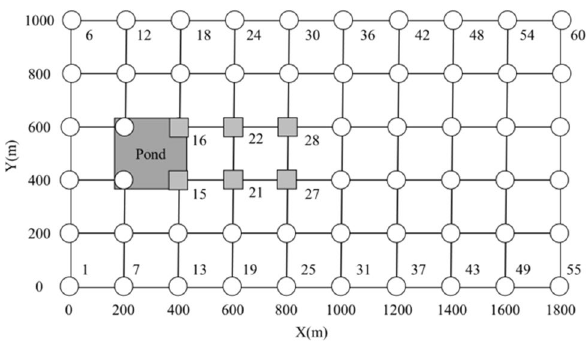
Fig. 6 FEM mesh for the study area